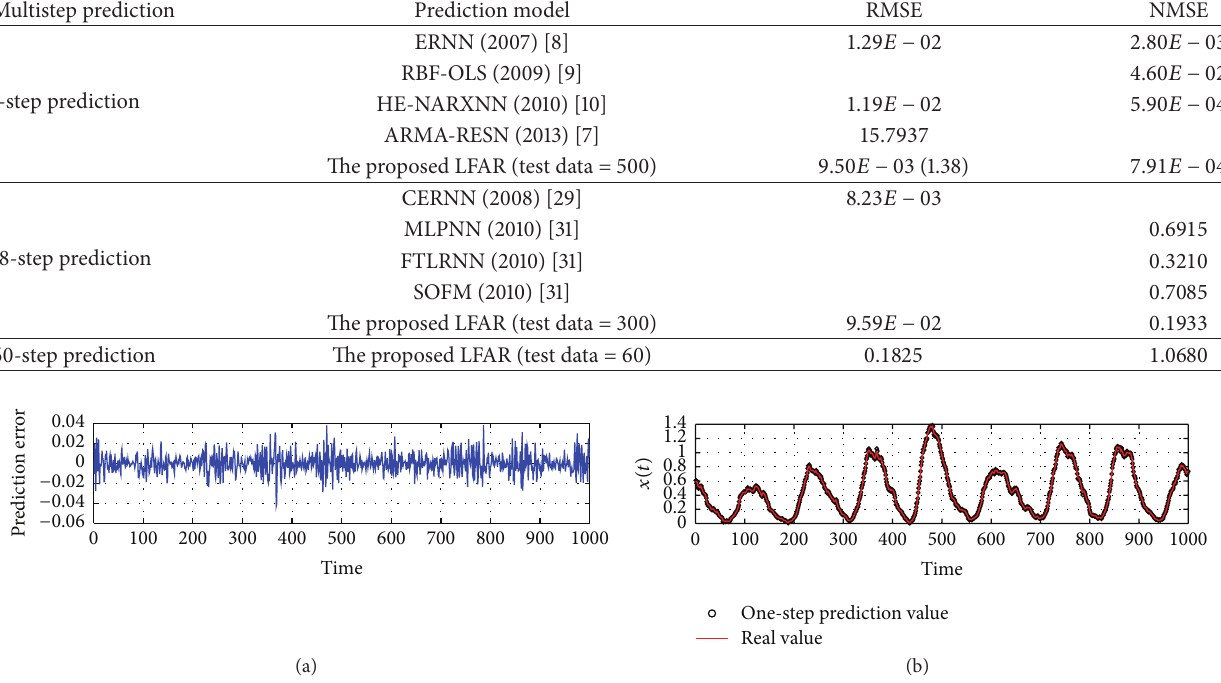
,𝑑 , ℎ ,𝑞 ,𝑚 , 𝜏 ) = (6, 2,1.3312, 139, 7,13) ). opt opt opt opt opt opt